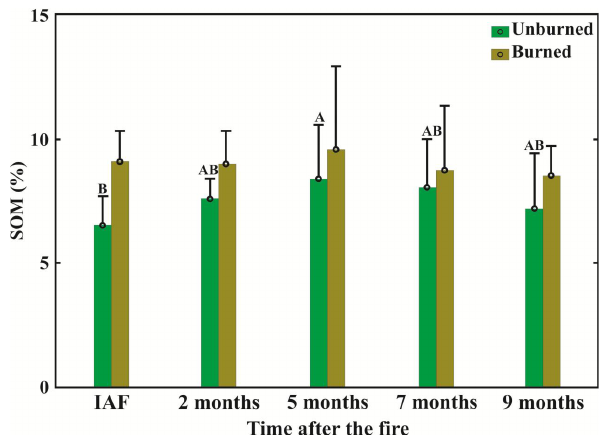
Fig. 2. Evolution of SOM content in the unburned and burned plots in the post-fire sampling dates (bars represent ± standard deviation). Different letters indicate significant differences ( p < 0.05) among times. IAF (Immediately After the Fire).